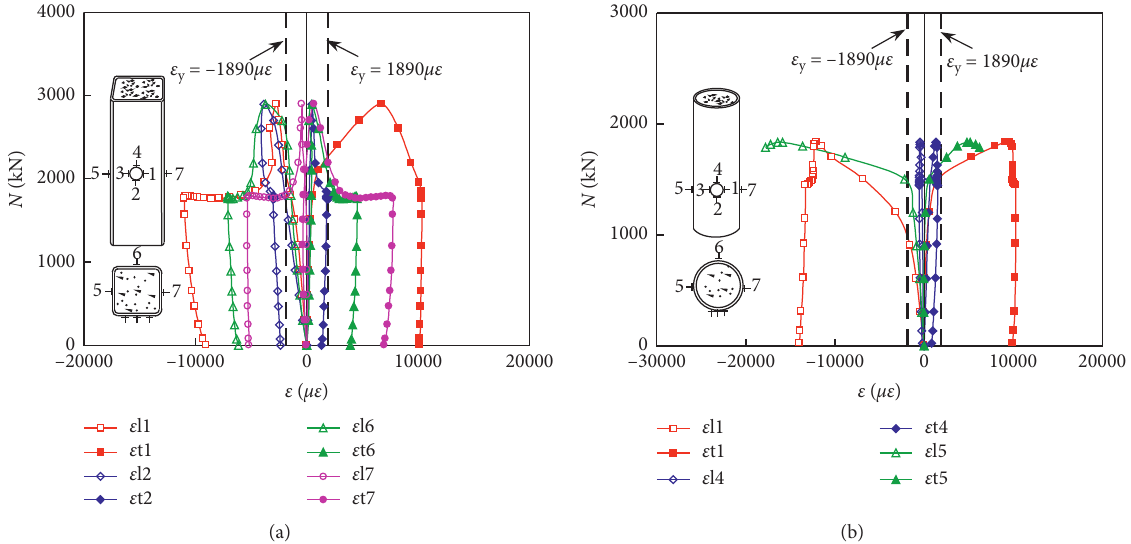
Figure 5: Typical load (N) versus strain ( eε ) relations of the tested columns. (a) Square section (s4-1). (b) Circular section (c3-1).